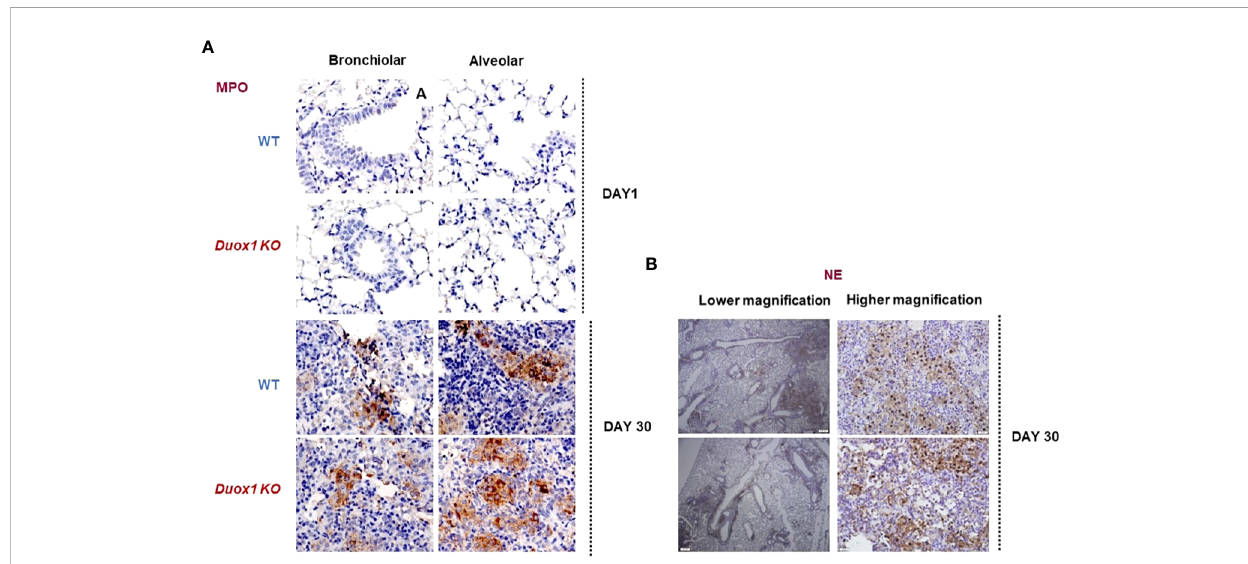
FIGURE 6 MPO and NE expressions in the lungs of Duox1 KO mice infected with Mtb . Mtb -infected lungs from Duox1 KO and WT mice were harvested at 1 or 30 day(s) post-infection, fi xed and processed for staining with rabbit anti-MPO or rabbit anti-NE antibodies followed by anti-rabbit secondary antibody (HRP-linked) and DAB ampli fi cation. Sections are counterstained with hematoxylin and representative micrographs are shown in panels. (A) Representative micrograph of MPO staining of Mtb -infected lungs (bronchiolar area) of Duox1 KO and WT mice at 1 and 30 day(s) post-infection. (B) Representative photomicrographs of NE in Mtb -infected lungs at 30 days post-infection, at low (200 µm) and high magni fi cation (20 µm), respectively. Duox1 KO, Duox1 -de fi cient; MPO, myeloperoxidase; NE, neutrophil elastase; WT,